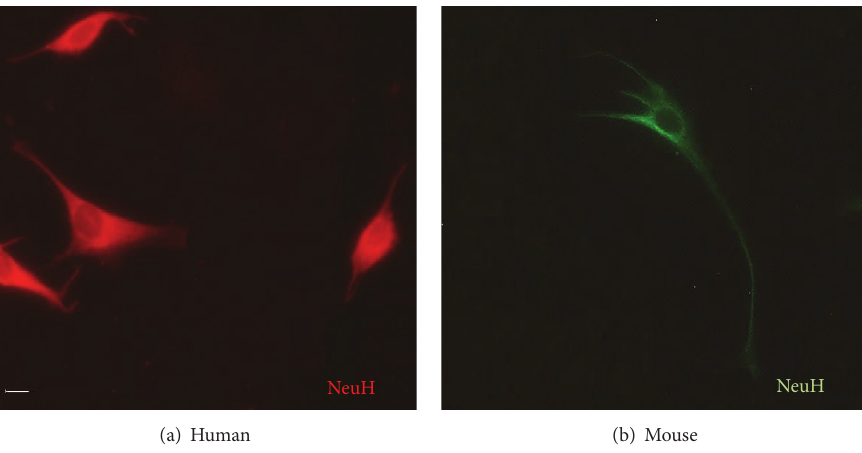
Figure 3: Neurons detected by using anti-NeuH in immunofluorescence assays. In immunofluorescence assays, neurons in primary cell cultures of either human central nervous system (CNS) (a) or (b) mouse brain tissue were identified with the neuron-specific cellular marker, NeuH. The secondary antibodies used contained rhodamine (a) or FITC (b) as fluorochromes. In green, FITC signal in mouse neurons is shownandinredrhodaminesignalisobservedinhumanneurons.Originalmagnificationwas400x,butthepictureswerecroppedtoimprove presentation.